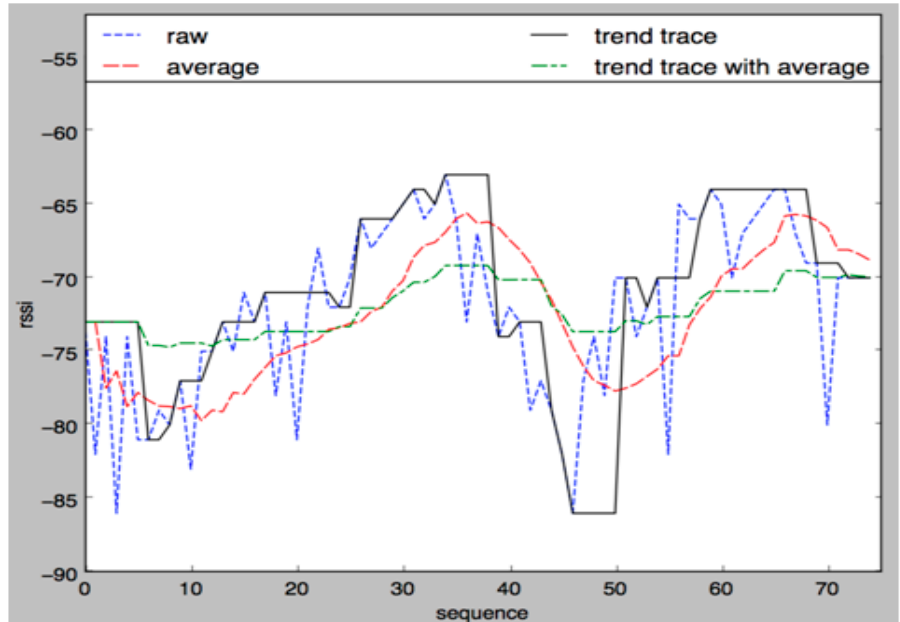
Figure 20. Signal Changes after Using a Smooth Filter. Figure 20. Signal changes after using a smooth